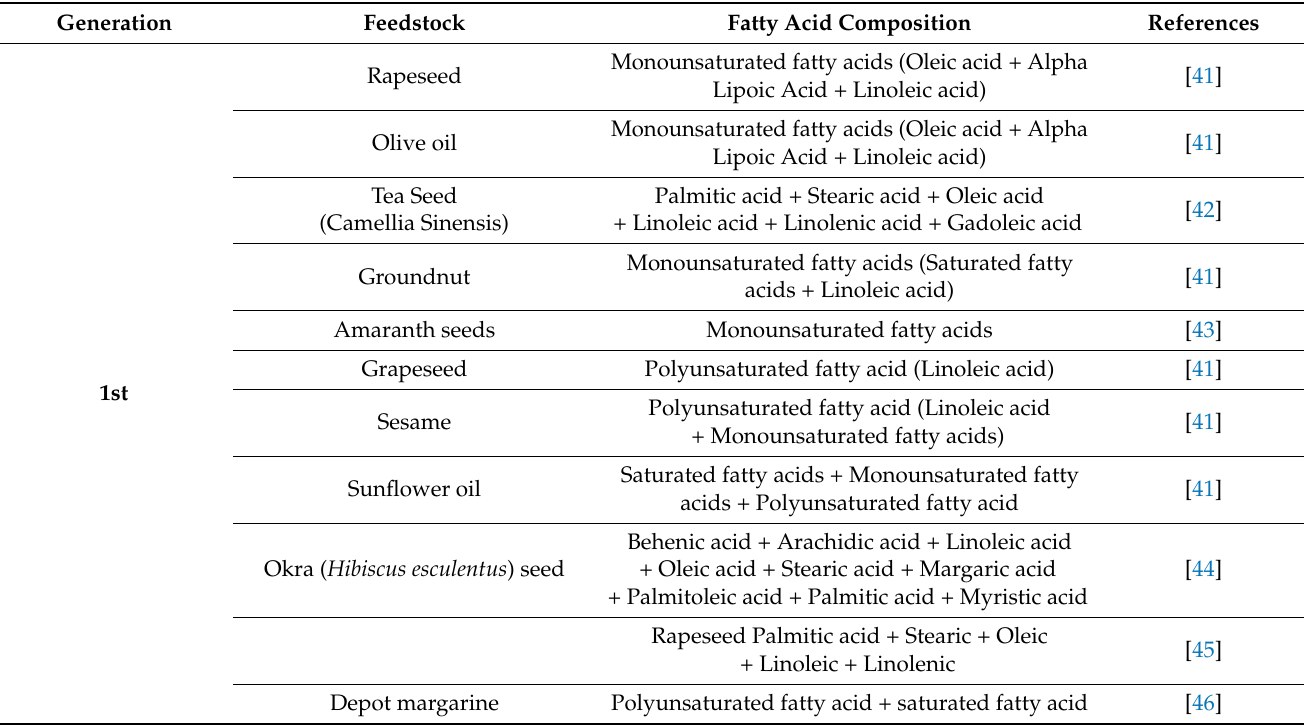
Table 1. Biodiesel feedstocks and their fatty acid composition. Generation Feedstock Fatty Acid